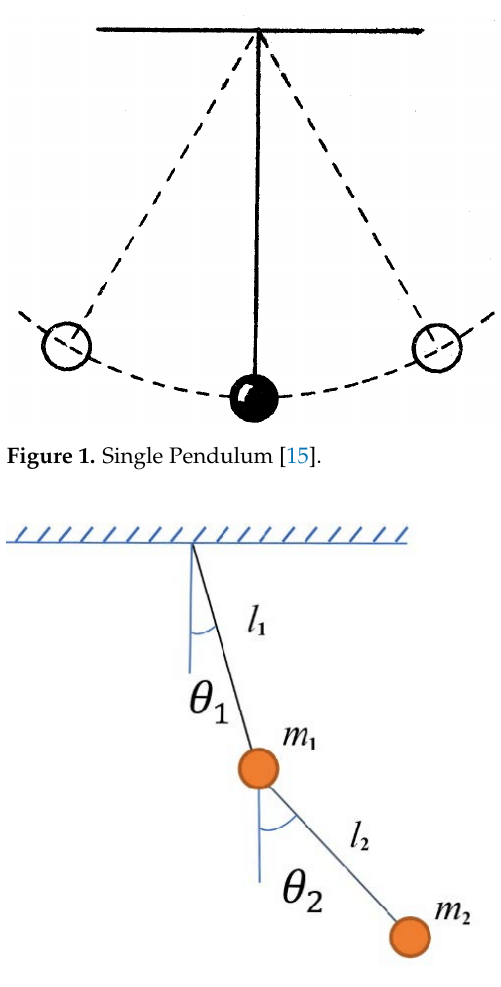
Figure 2. Double Pendulum